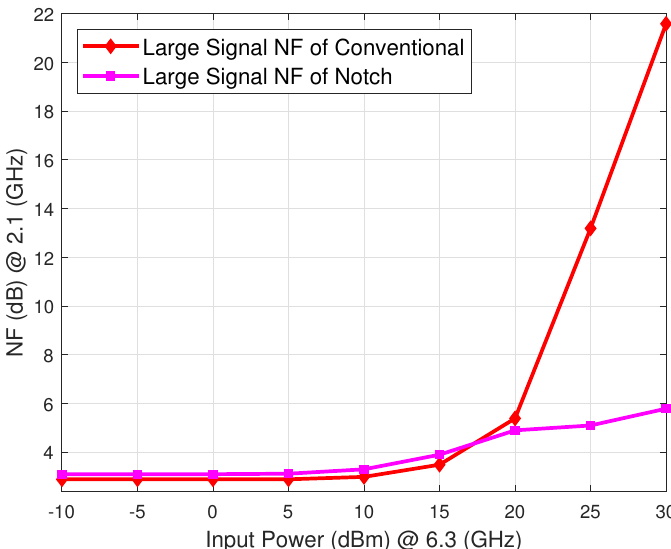
Figure 7. Large signal noise figure performance of the proposed notch LNA compared to the conventional LNA.